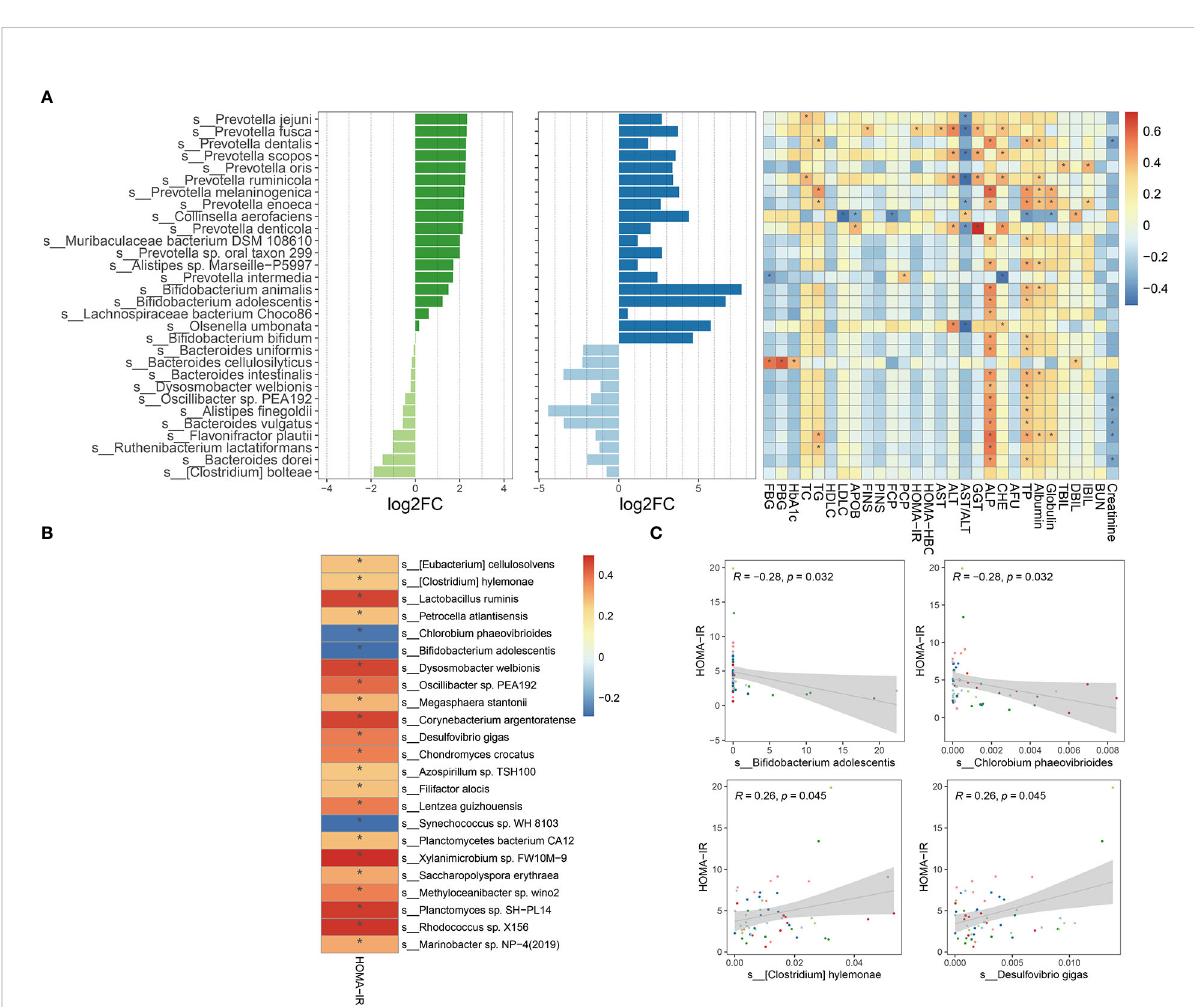
FIGURE 7 Microbial species signi fi cantly changed after intervention and their correlation with clinical indicators. (A) The top 30 signi fi cantly changed species after FMT or FMT plus metformin and their correlation with clinical indicators based on samples from W0 and W4 of these two groups. (B) Signi fi cant corrections between HOMA-IR and signi fi cantly changed species with relative abundance greater than 0.001%, based on all samples from T2DM patients at W0 and W4 in metformin, FMT alone, and FMT plus metformin group. (C) 4 gut microbes signi fi cantly related to HOMA-IR. "*" means that P value is < 0.05.